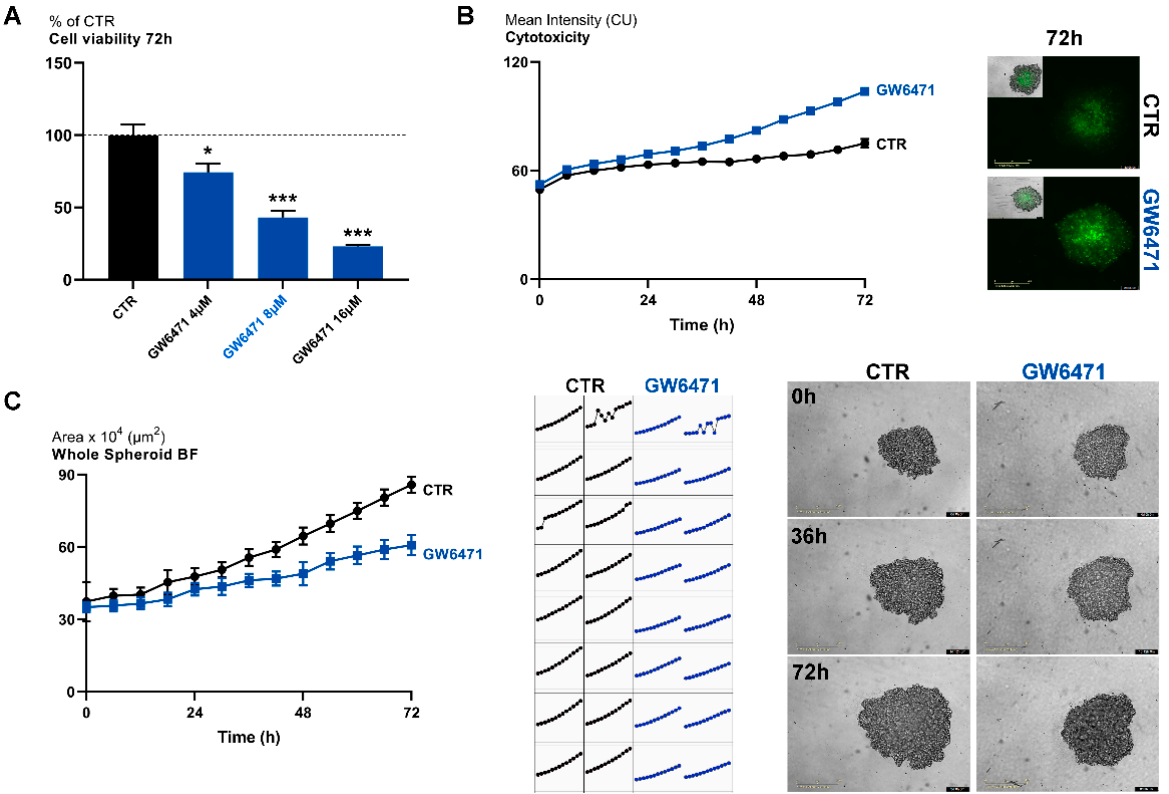
Figure 1. ( A ) MTS assay for mammospheres treated with different concentrations of GW6471 for 72 h. *** p < 0.0005; ** p < 0.005; * p < 0.05 vs. control (CTR) ( n = 3). Dot line indicates the control level. ( B ) Live-cell IncuCyte cytotoxicity assay in mammospheres treated with 8 µM of GW6471 for 72 (marked in green; n = 3). Scale bar: 400 µm. ( C ) Whole spheroid bright field analyzed with IncuCyte 3D single spheroid assay. A representative figure for CTR and GW6471-treated cells at different time points is shown ( n = 3). For p values relative to IncuCyte assay please see Supplementary Table S1. Scale bar: 400 µm.